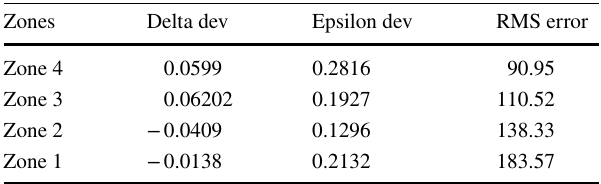
Fig. 7 Zones for extraction of anisotropy were defined by the seismic reflection pattern. Four zones are defined Table 1 Anisotropic values extracted along the well in different zones assuming weak anisotropy